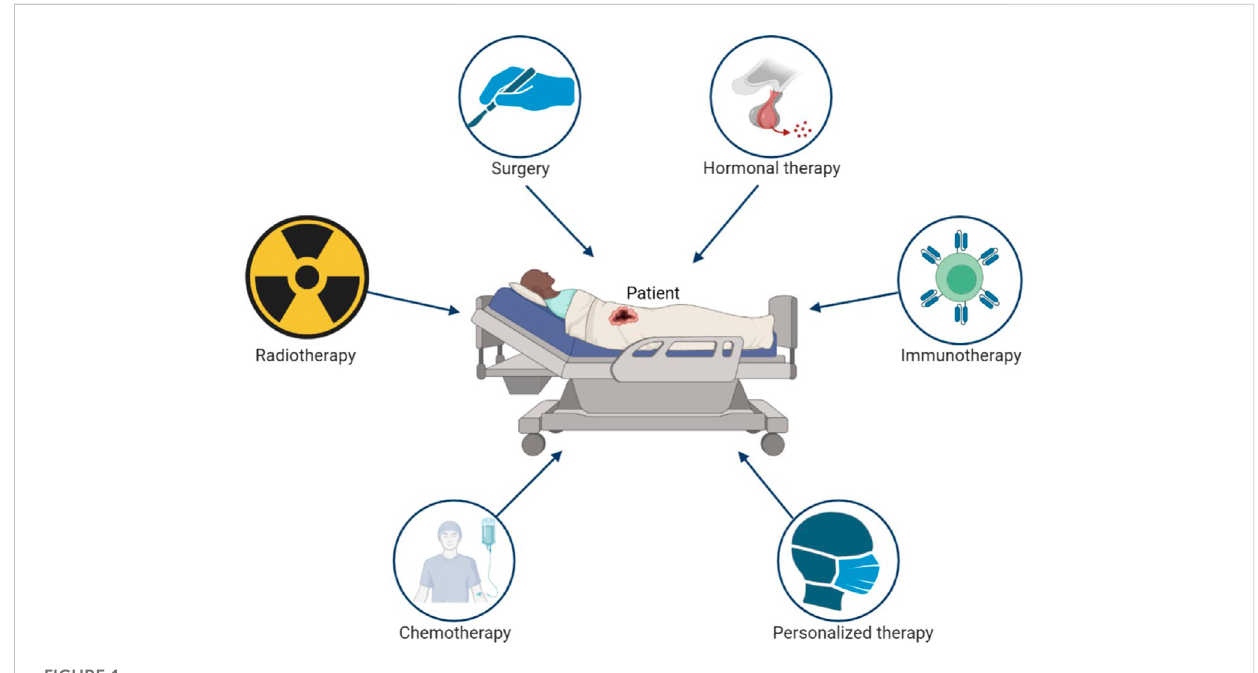
FIGURE 1 The main treatment strategy of